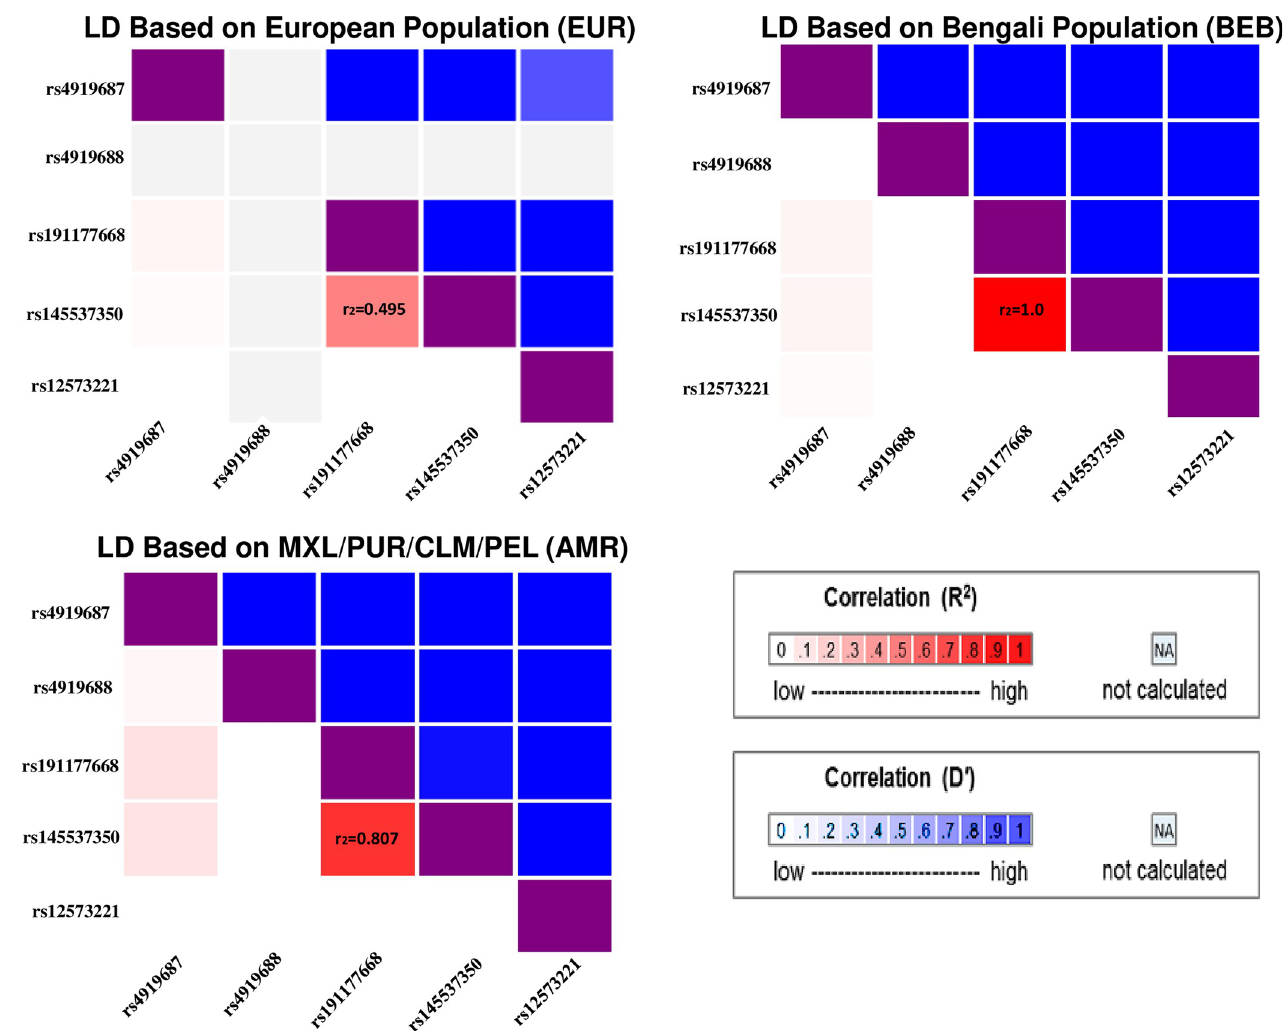
Fig 3. Linkage Disequilibrium (LD) among DMA% lead SNPs in multiple reference populations. All LD estimates are based on 1,000 Genomes data obtained from LDLink. We observe strong LD (r2 = 0.495–1.0) between rs145537350 (HEALS) and rs191177668 (NHSCS and SHS), but weak LD among all other variants.